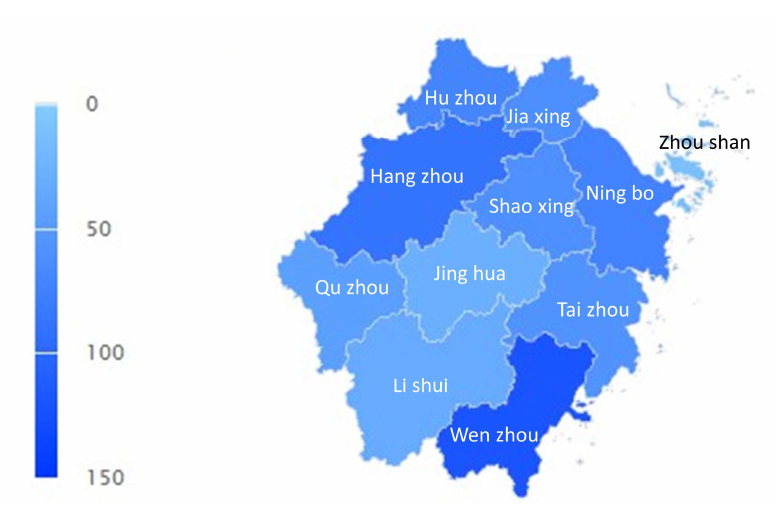
Figure 2. Map of questionnaire data sources.